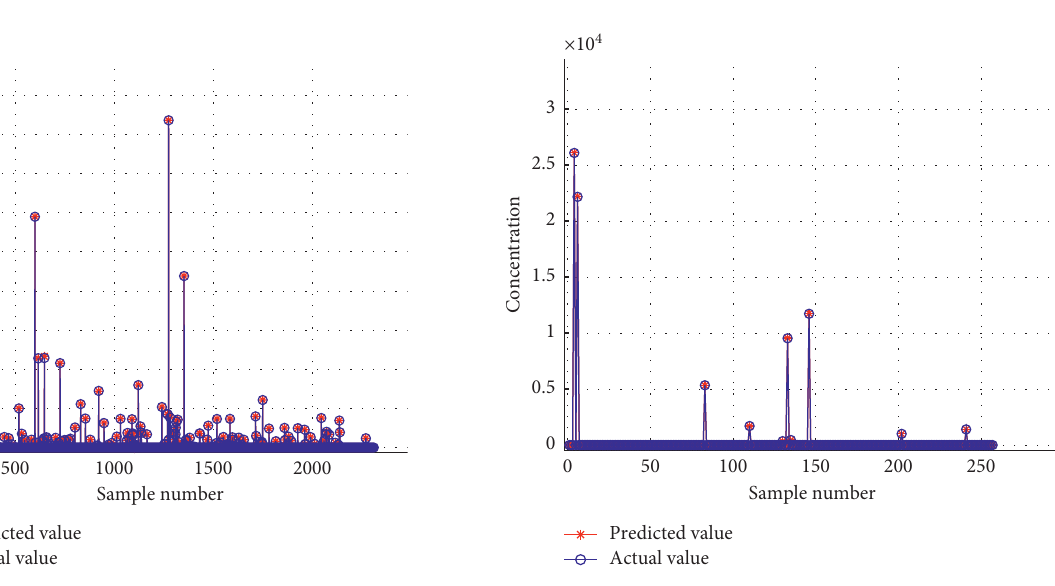
Figure 18: The fitting effect diagram of Laiwu training set data. Figure 19: The Laiwu test set data prediction effect